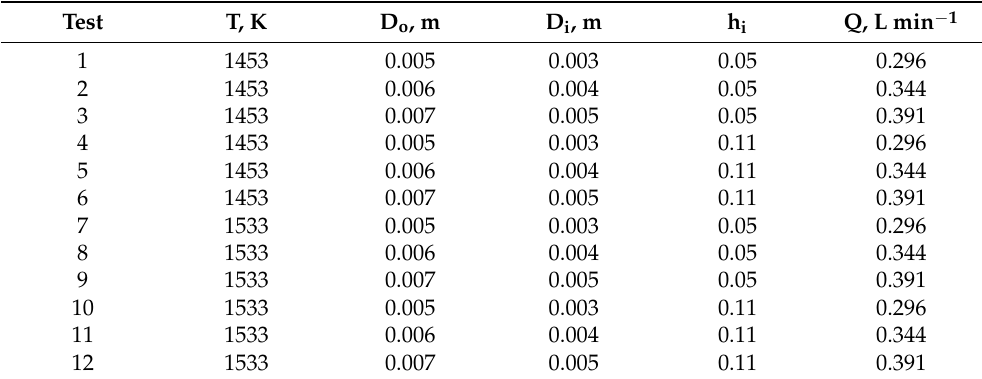
Table 1. Experimental design of the conversion kinetic